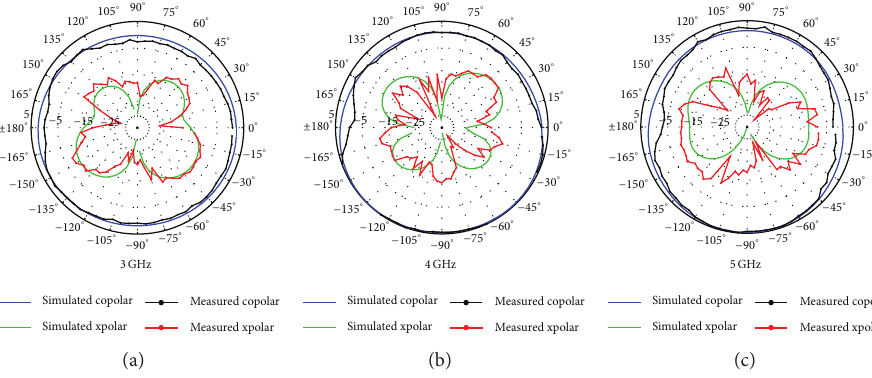
Figure 7: Simulated and measured radiation pattern in the H-plane (xoz) (10dB/div).